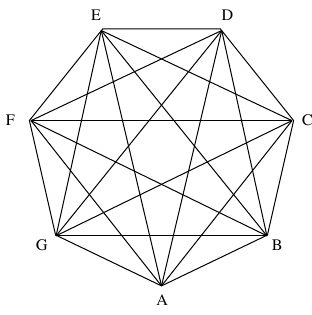
Figure 1 . The E 7 entanglement diagram from [1]. Each of the 7 vertices A,B,C,D,E,F,G represents Figure 1: The E 7 entanglement diagram. Each of the seven vertices A,B,C,D,E,F,G rep- resents a qubit and each of the seven triangles ABD, BCE, CDF, DEG, EFA, FGB, GAC a qubit and each of the 7 triangles ABD, BCE, CDF, DEG, EFA, FGB, GAC describes a tripartite describes a tripartite entanglement.